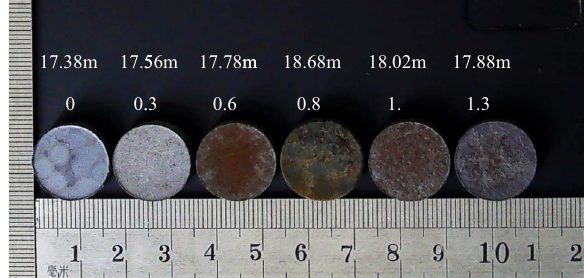
Figure 8: Morphology of reduced briquettes with di ff erent basicity values fi red at 1,250°C and reduction for 60